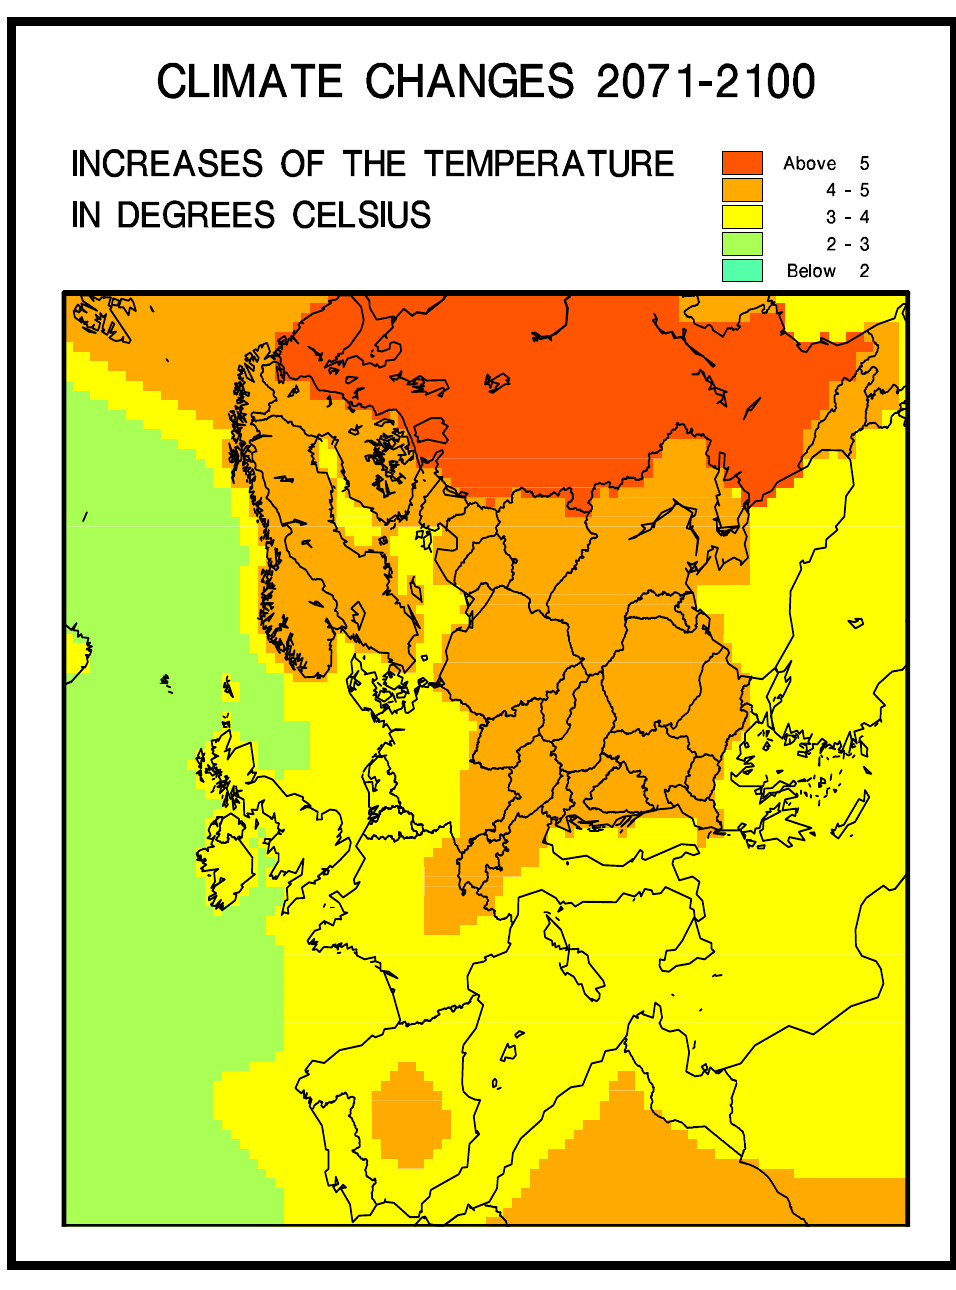
Figure 2. Expected increases of the temperature in first horizontal level of the space domain of UNI-DEM according to the IPCC reports.